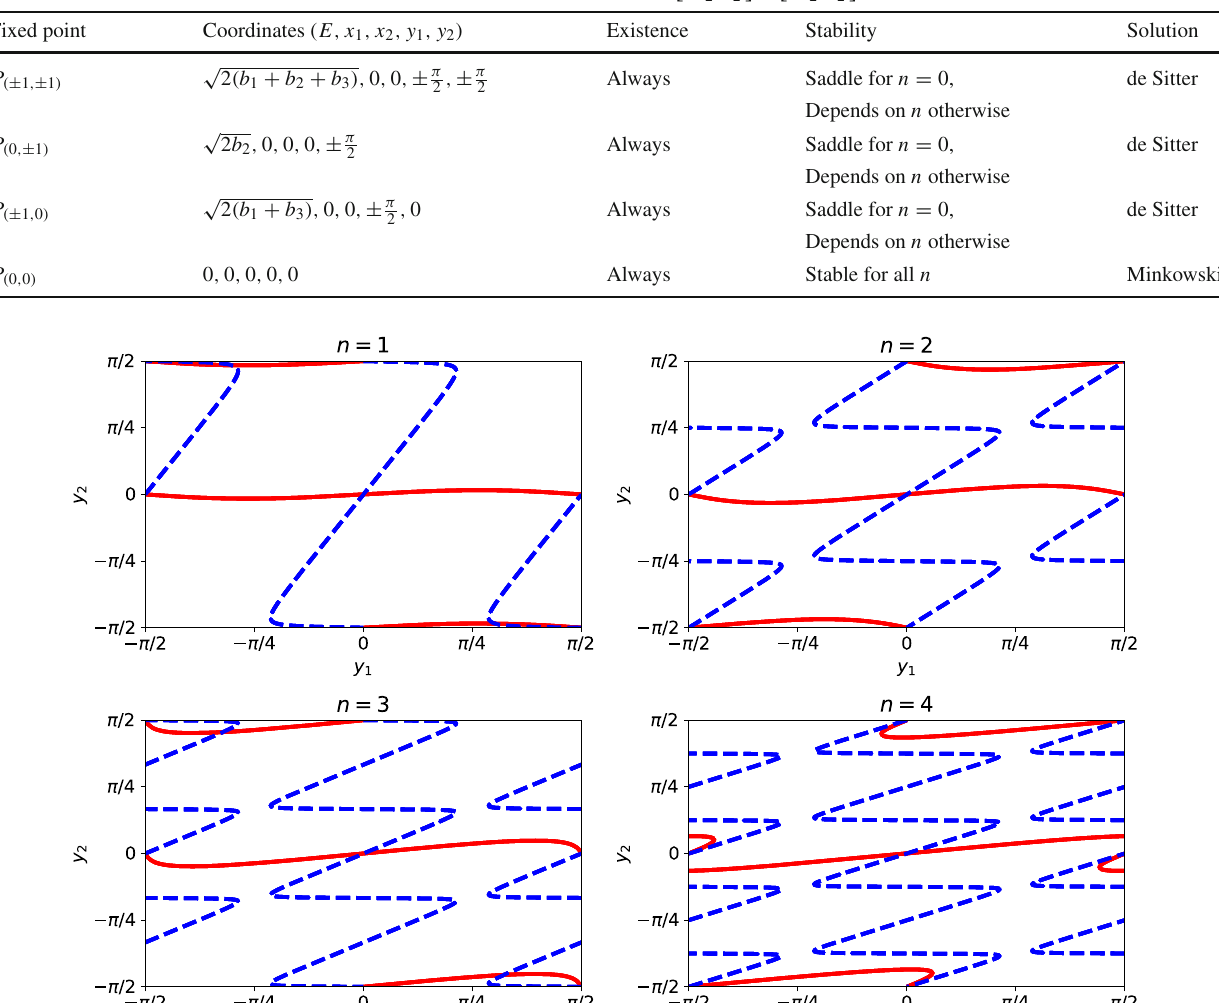
" # " # − π , π , π × − π 2 2 2 2